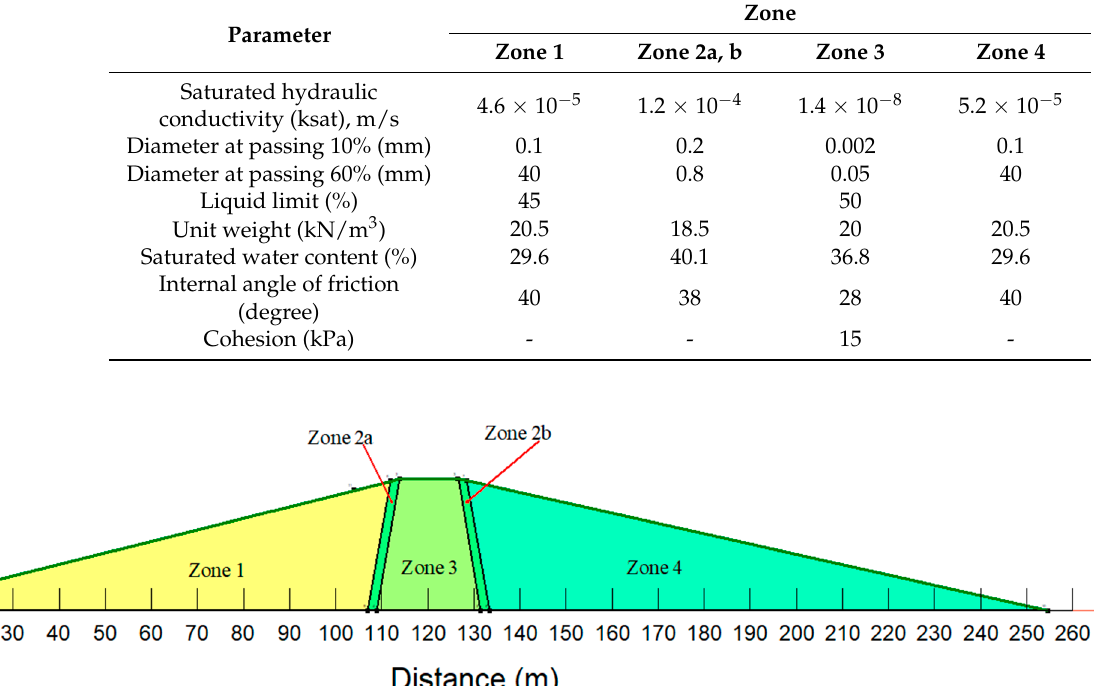
Table 3. Embankment material properties.